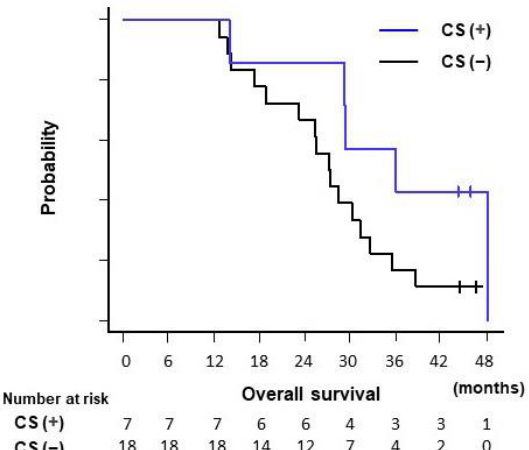
Figure 2. Kaplan – Meier curves for PFS and OS in the CRT and CTx groups. OS, overall survival; PFS, progression-free